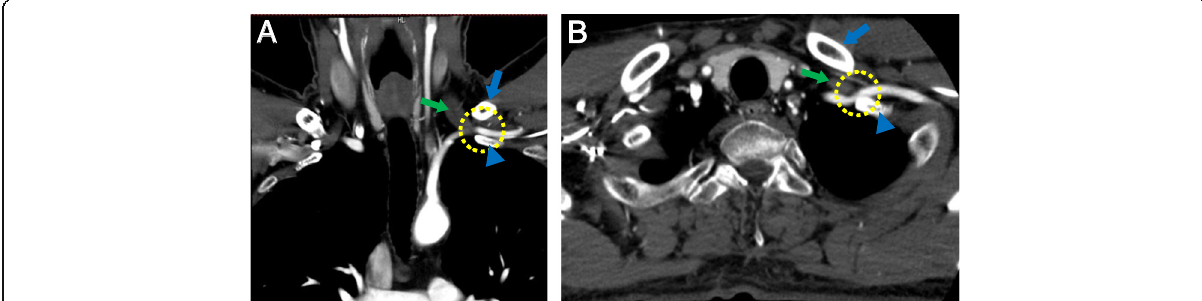
Fig. 2 Preoperative enhanced CT ( a coronal view, b axial view). Yellow dotted circles indicate the slightly compressed left subclavian artery in the left costoclavicular space. (blue arrow: clavicle, blue triangle: the first rib, green arrow: anterior scalene